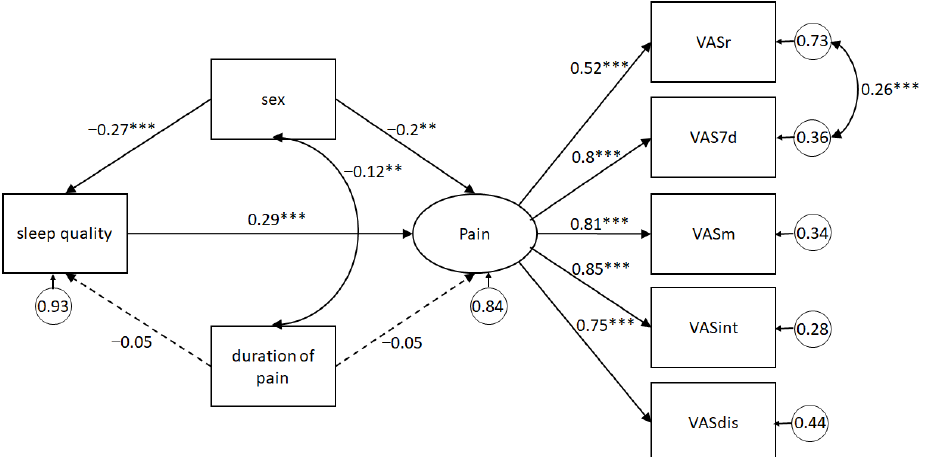
Figure 2. Structural equation model predicting pain from sleep quality, controlling for sex and pain duration. Note: Statistics are standardized regression coefficients. Dotted lines represent non- significant relations; bold lines represent significant paths. The curve lines correspond to covariation between variables or their errors. VASr, VAS at rest; VAS7d, average VAS 7 days; VASm, VAS at movement; VASint, VAS pain interference; VASdis, VAS distress relative to pain. * p < 0.05, ** p < 0.01, *** p < 0.001.